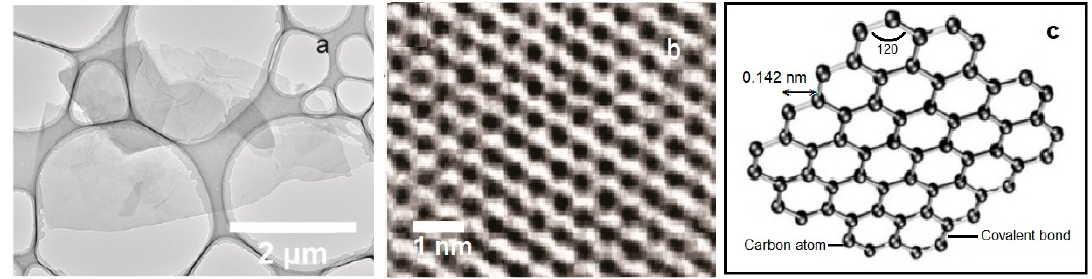
Figure 12. Morphological characterization of graphene structure. ( a ) Transmission electron microscopy image at low magnification showing several overlapping graphene flakes [43], ( b) spherical aberration-corrected high-resolution transmission electron microscopy image of the honeycomb structure of a graphene single-layer sheet [44], ( c ) Single graphene nanosheet [45]. Partially reprinted with the permission of the authors